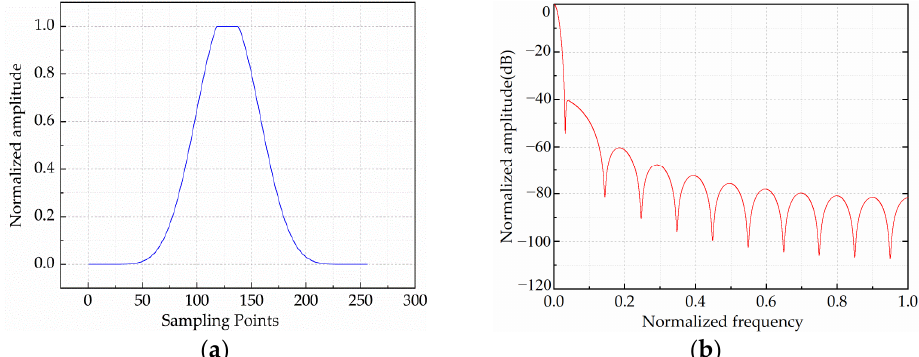
Figure 2. ( a ) The quasi-trapezoidal window function time-domain waveform; ( b ) the quasi-trapezoidal window function amplitude-frequency response.